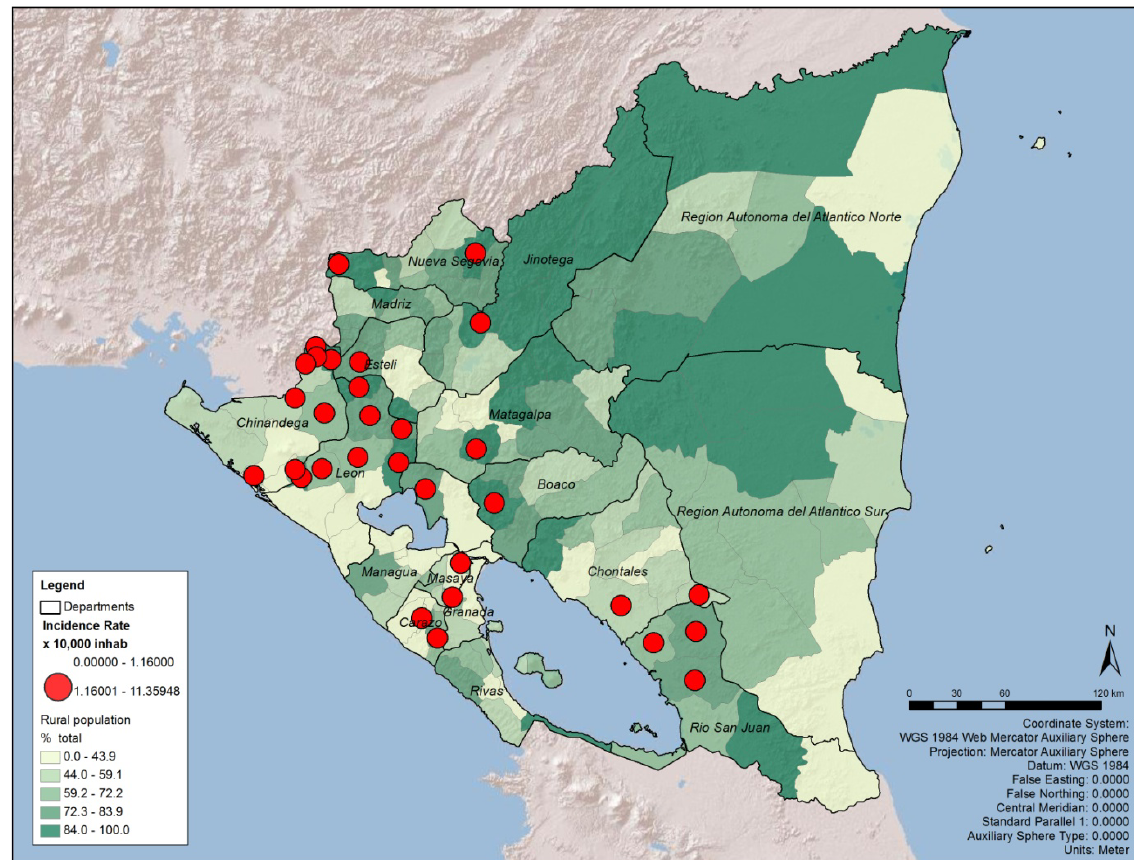
Figure 7. Critical areas for leptospirosis define by incidence rate and percentage of rural population, Nicaragua, by municipality